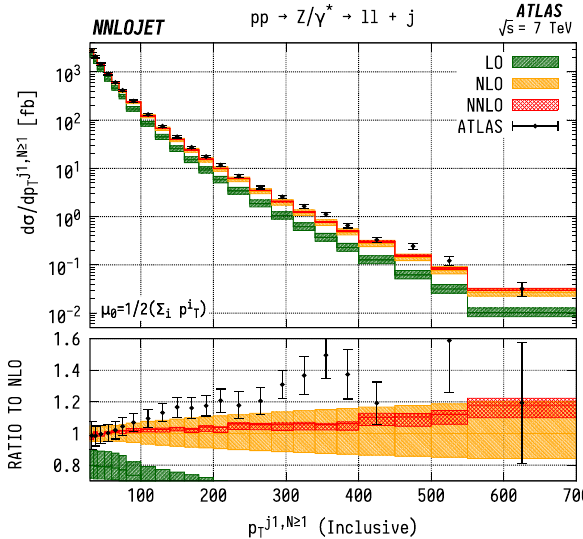
Fig. 17 ZJ cross section differential in the transverse momentum p T of the leading jet for events with one or more associated jets ( N ≥ 1 ) . See Fig. 15 for